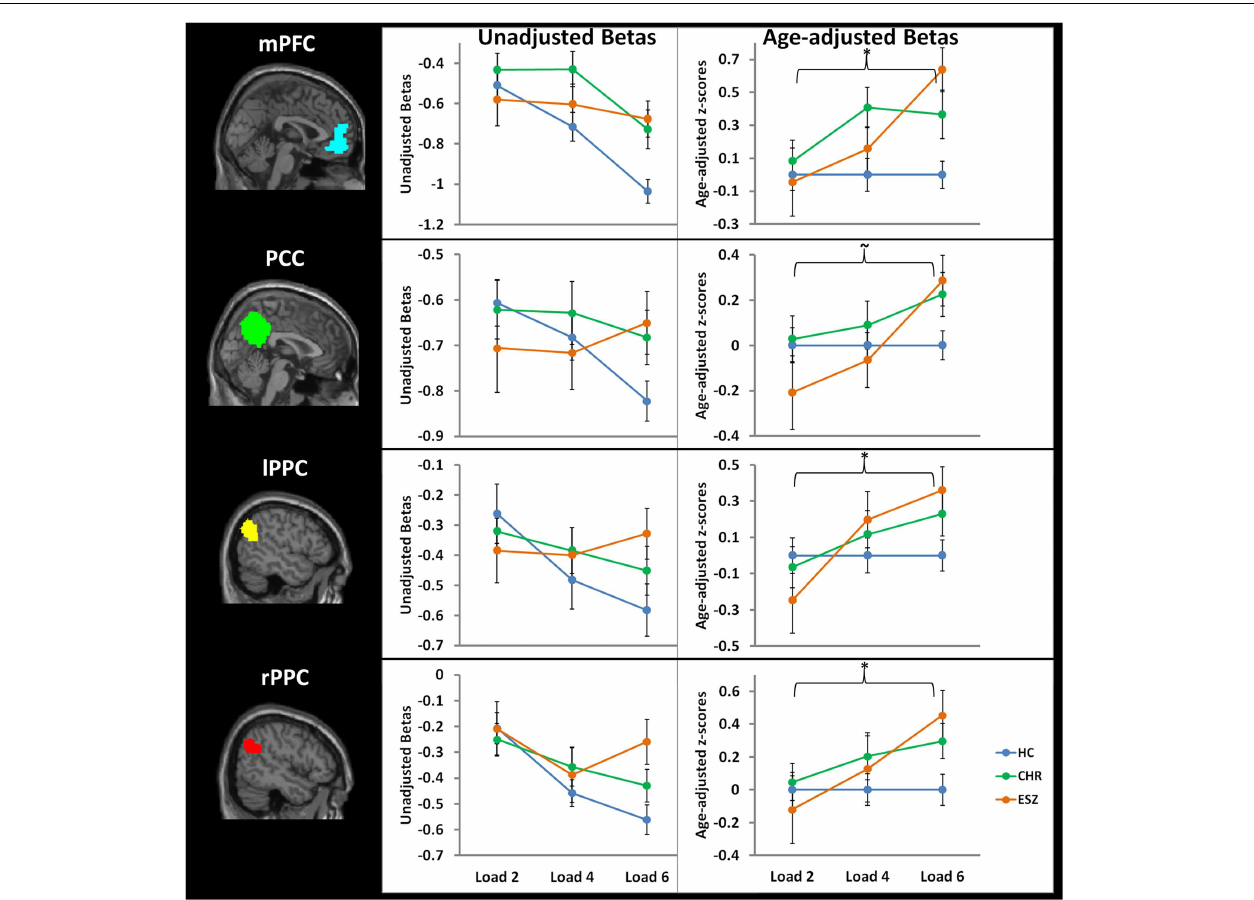
FIGURE 3 | Four default mode network regions-of-interest (ROIs) were interrogated for group-by-load interaction effects: medial prefrontal cortex (mPFC), posterior cingulate cortex (PCC), left lateral posterior parietal cortex (lPPC), and right lateral posterior parietal cortex (rPPC). Line graphs display each ROI’s mean fMRI contrast value ( ± standard error) by Group, for low (two-item), medium (four-item), and high (six-item) working memory loads during the probe condition. Unadjusted (left) and age-adjusted (right) data are shown in figure panels.° °Statistical tests of age-adjusted extracted fMRI data (* p < 0.05; ∼ 0.08 < p < 0.05): data were adjusted for participant age via a z -scoring procedure based on an age regression within the HC group to model normal aging effects. As a result, for each voxel in the brain, the age-adjusted z -scores in the HC group have a Mean = 0; SD = 1, and the means in the patient groups reflect the degree and direction of abnormality, in standard units, from the HC-derived age-specific norms. *rmANOVA medial prefrontal cortex ROI, main effect of group: F (2, 105) = 4.35, p = 0.02 *rmANOVA medial prefrontal cortex ROI, interaction effect of group-by-load: F (4, 210) = 2.69, p = 0.03 One-way ANOVA at load 2, main effect of group: F (2, 105) = 0.20, p = 0.82 *One-way ANOVA at load 4, main effect of group: F (2, 105) = 3.36, p = 0.04;Tukey–Kramer HSD post hoc tests, HC < CHR, p = 0.03 *One-way ANOVA at load 6, main effect of group: F (2, 105) = 7.57, p = 0.001;Tukey–Kramer HSD post hoc tests, HC < CHR, p = 0.05; HC < ESZ, p = 0.001 rmANOVA posterior cingulate cortex ROI, main effect of group: F (2, 105) = 0.83, p = 0.44 ∼ rmANOVA posterior cingulate cortex ROI, interaction effect of group-by-load: F (4, 210) = 2.36, p = 0.06 One-way ANOVA at load 2, main effect of group: F (2, 105) = 1.13, p = 0.33 One-way ANOVA at load 4, main effect of group: F (2, 105) = 0.51, p = 0.60 *One-way ANOVA at load 6, main effect of group: F (2, 105) = 3.38, p = 0.04;Tukey–Kramer HSD post hoc tests, HC < ESZ, p = 0.07 rmANOVA right lateral posterior parietal cortex ROI, main effect of group: F (2, 105) = 1.04, p = 0.36 *rmANOVA right lateral posterior parietal cortex ROI, interaction effect of group-by-load: F (4, 210) = 2.50, p = 0.04 One-way ANOVA at load 2, main effect of group: F (2, 105) = 0.31, p = 0.73 One-way ANOVA at load 4, main effect of group: F (2, 105) = 0.70, p = 0.50 *One-way ANOVA at load 6, main effect of group: F (2, 105) = 4.23, p = 0.02;Tukey–Kramer HSD post hoc tests, HC < ESZ, p = 0.02 rmANOVA left lateral posterior parietal cortex ROI, main effect of group: F (2, 105) = 0.42, p = 0.66 *rmANOVA left lateral posterior parietal cortex ROI, interaction effect of group-by-load: F (4, 210) = 3.05, p = 0.02 One-way ANOVA at load 2, main effect of group: F (2, 105) = 0.90, p = 0.41 One-way ANOVA at load 4, main effect of group: F (2, 105) = 0.66, p = 0.52 ∼ One-way ANOVA at load 6, main effect of group: F (2, 105) = 2.84, p = 0.06;Tukey–Kramer HSD post hoc tests, HC < ESZ, p =